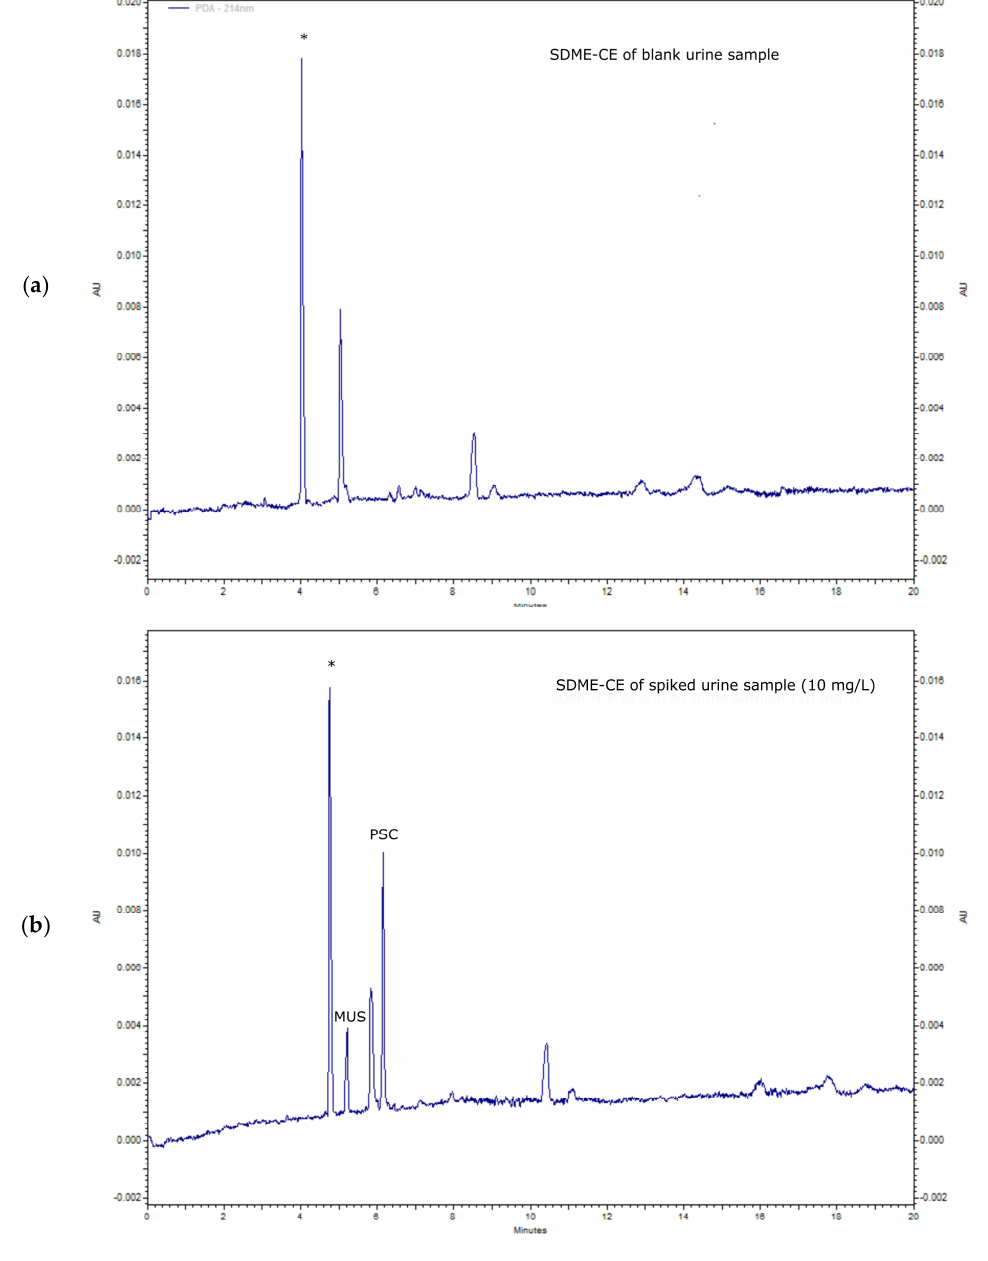
Figure 4. SDME-CE analysis of urine samples: electropherograms of ( a ) blank urine and ( b ) spiked urine sample with PSC and MUS (10 mg L − 1 ). SDME-CE conditions: BGE—25 mM phosphate bu ff er pH 3 (also acceptor phase); Sample volume: 200 µ L of blank urine or spiked urine; Organic phase (single drop): octanol; Extraction time: 180 s; Injection: 0.1 psi, 1s; n = 6, RSD < 8.5%).*